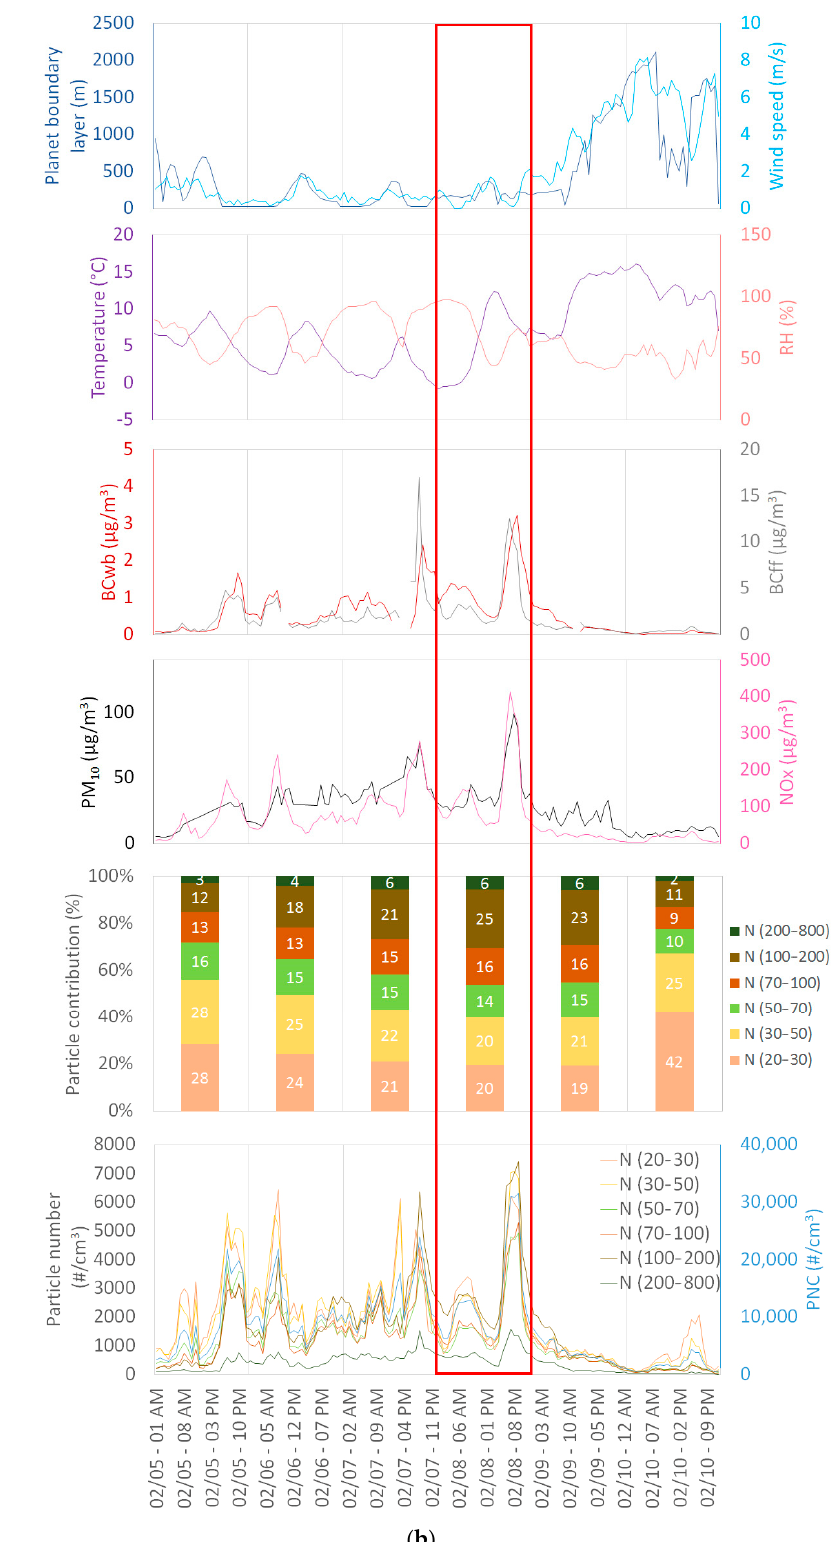
Figure 10 Figure 10. Variations of pollutants and meteorological parameters during ( a ) 24 and 25 January, 2020 episode, and ( b ) 8 February, 2020 episode, framed in red. Both episodes presented the same increase for the 20–30 nm and 30–50 nm size channels from 27 January and 10 February, respectively. On the contrary, a clear drop